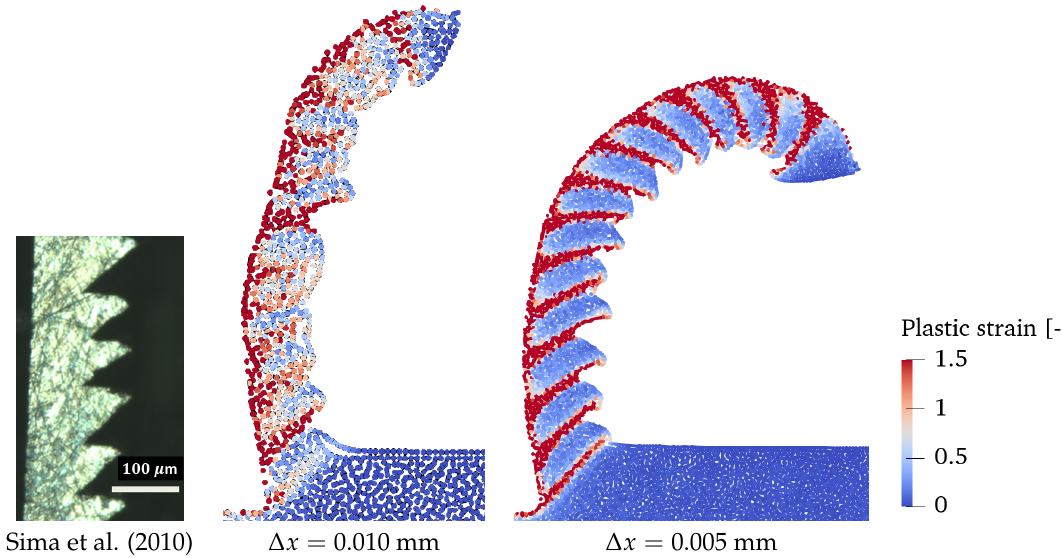
Sima et al. (2010) ∆ x = 0.010 mm Figure 10. Comparison of chip shapes in different SPH resolutions, where v c = 241 m/min, t u = 0.1 mm, and r β = 0.005 mm. The experimental photograph reprinted from Sima et al. [42] Copyright (2021), with permission from Elsevier under License Number